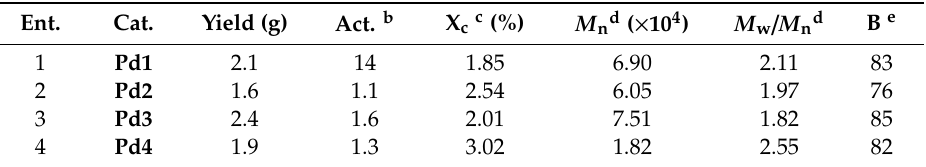
Table 2. Pd catalyzed ethylene copolymerizations.